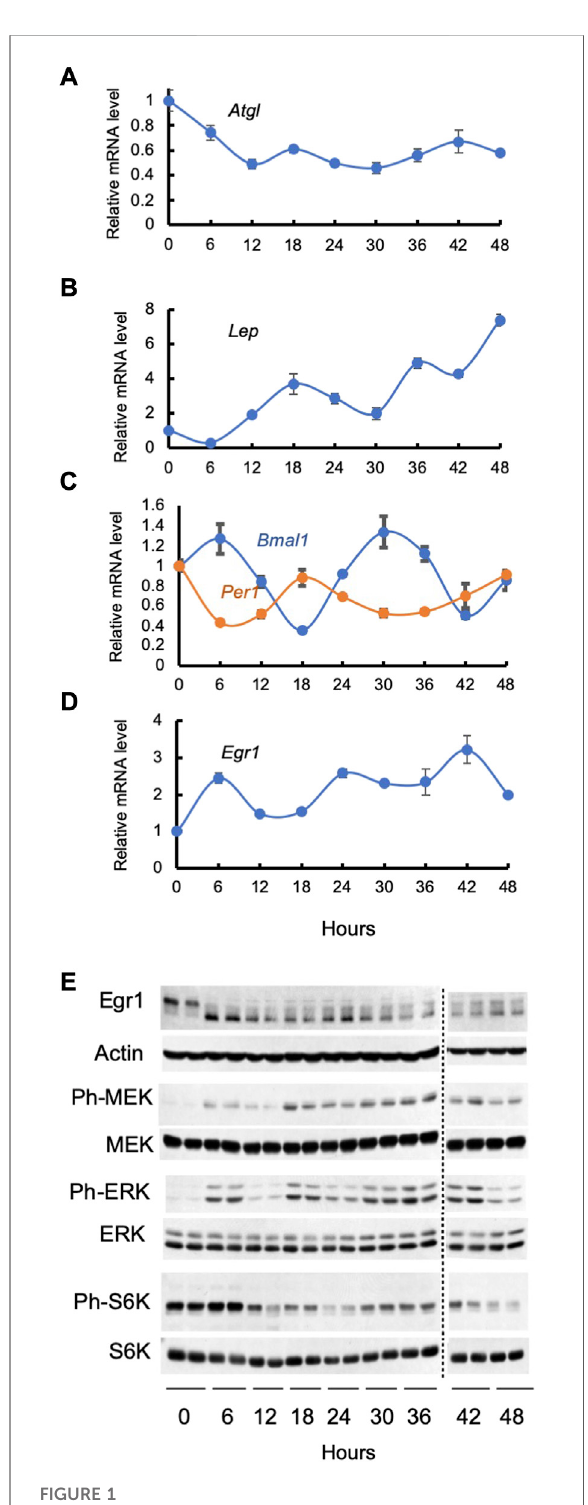
FIGURE 1 Cell autonomous oscillations in synchronized 3T3-L1 adipocytes. Cells were serum starved for 2 h, treated with 50% horse serum for 2 h, washed, and monitored for the next 48 h under normal culturing conditions without serum. Panels (A – D) : levels of various mRNAs were determined by qPCR data